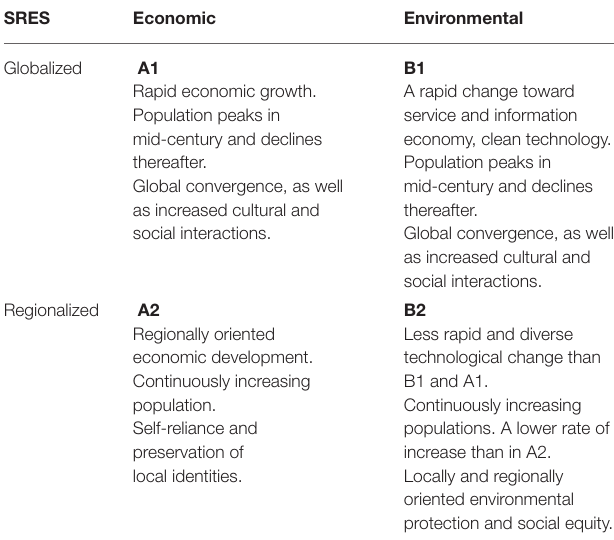
TABLE 2 | General description of the four